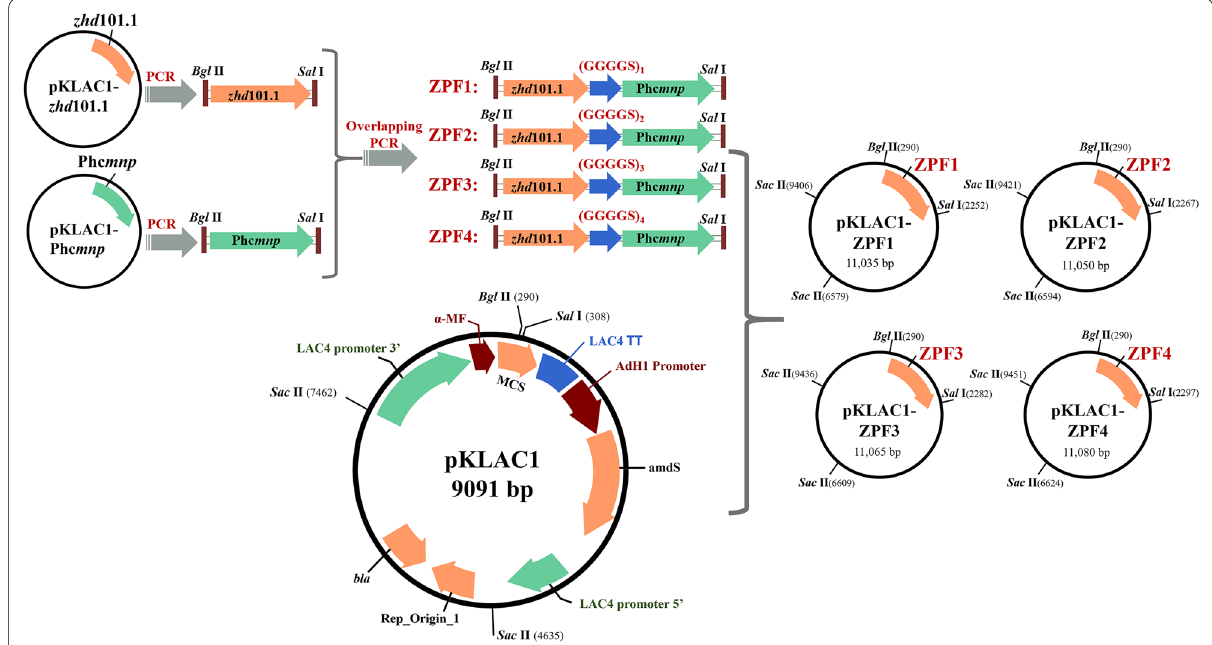
Fig. 1 Flowchart for construction of fusion genes and recombinant